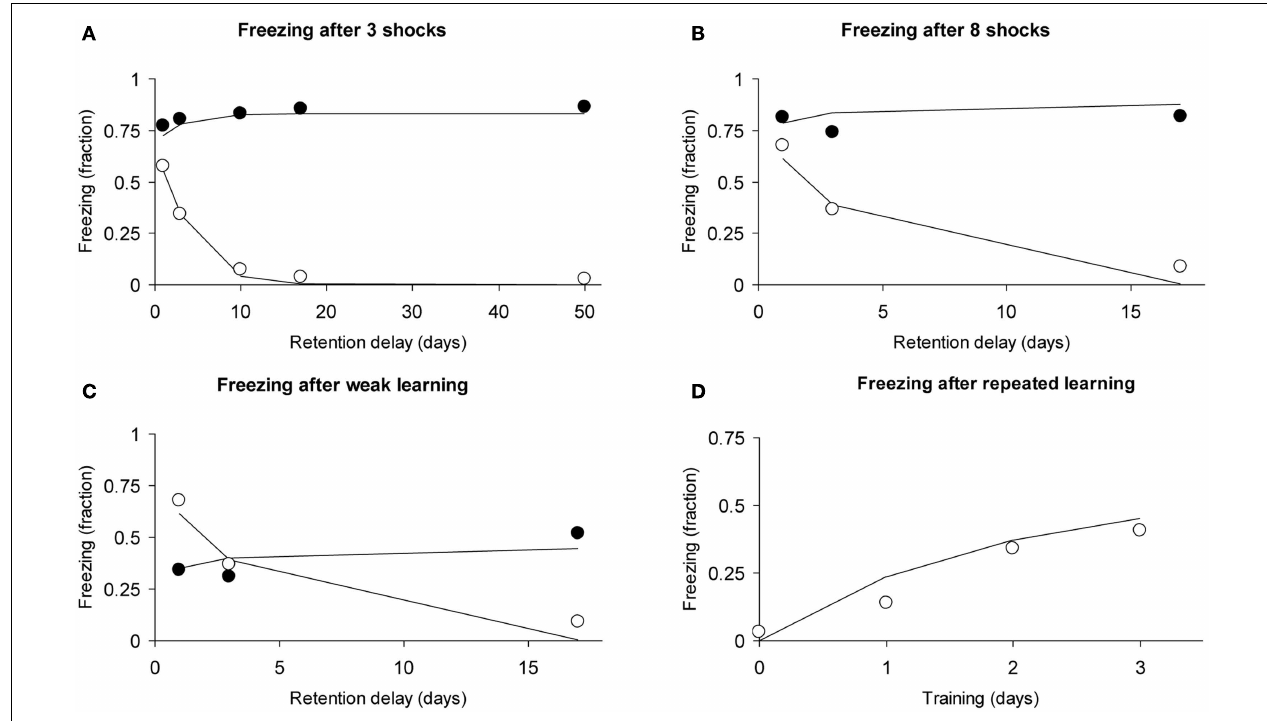
curves after learning with eight foot shocks. (C) Forgetting curves after learning with one foot shock (controls) and eight foot shocks (experimental). (D) Repeated learning in experimental animals receiving one foot shock per day.The observed data are averaged over two conditions (see text for